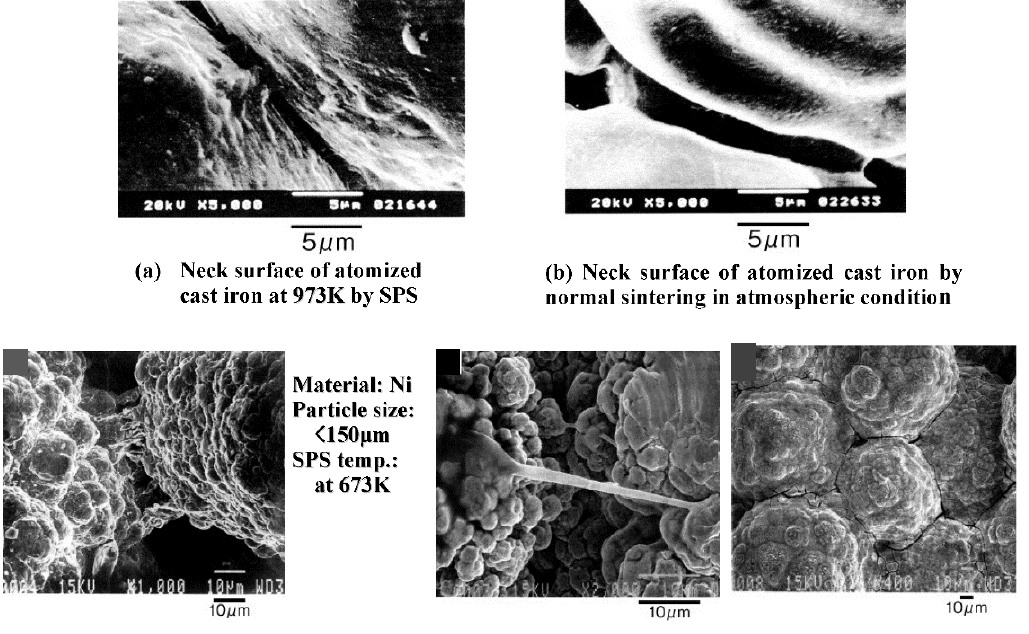
Figure 12. Collateral evidence examples of SPS effects on metallic materials [33,35].